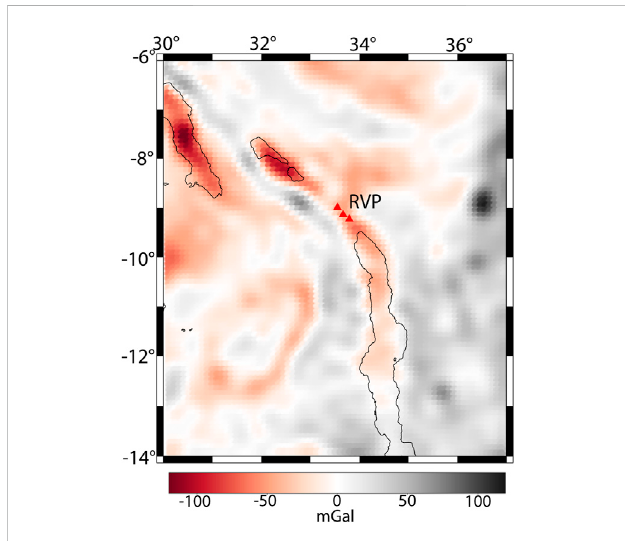
FIGURE 2 Bouguer gravity anomaly map extracted from the Experimental Global Gravity Field Model (XGM 2016; Pail et al., 2018). RVP = Rungwe Volcanic Province. Red triangles from north to south represent the three active Holocene volcanoes (Ngozi, Rungwe, and Kyejo; Harkin, 1962; Fontijn et al., 2010) of the RVP. The Holocene volcanoes are from theSmithsonian Global Volcanism Program (Global Volcanism Program, 2013). Black lines indicate the outline of rift